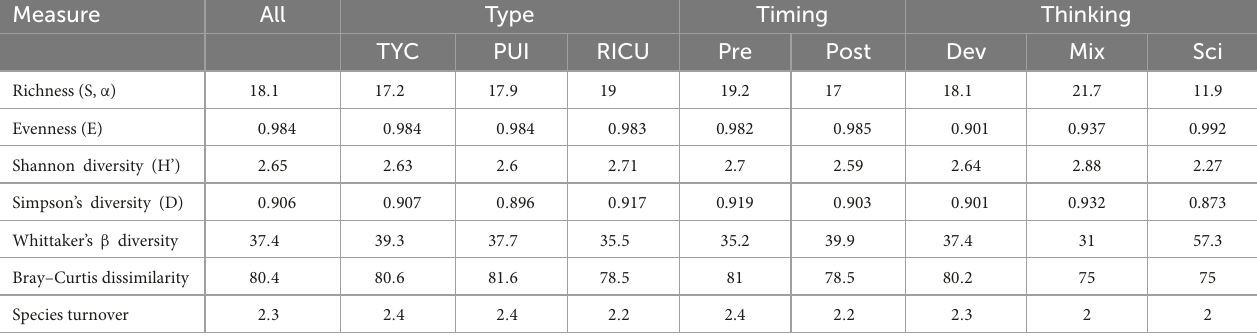
TABLE 3 Ecological diversity